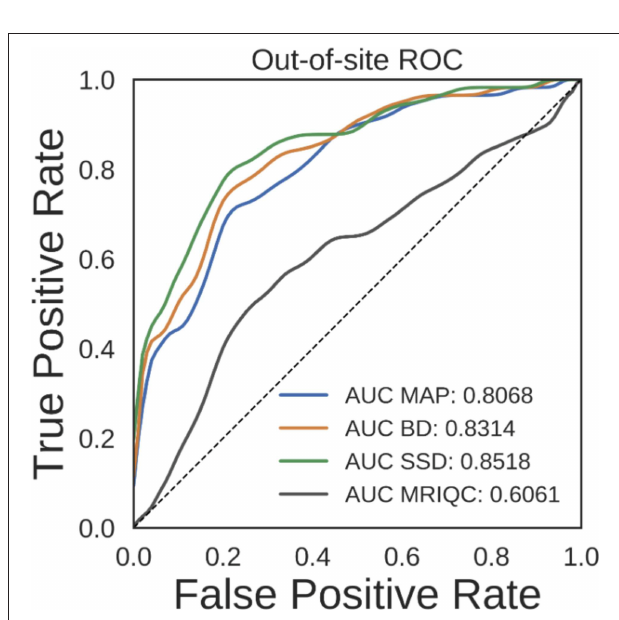
FIGURE 7 | Receiver operating characteristic (ROC) curves for predicting scan quality for the NNDSP out-of-site test set from the average non-background voxel uncertainty of the maximum a posteriori (MAP), MC Bernoulli dropout (BD), and spike-and-slab dropout (SSD) networks and from MRIQC